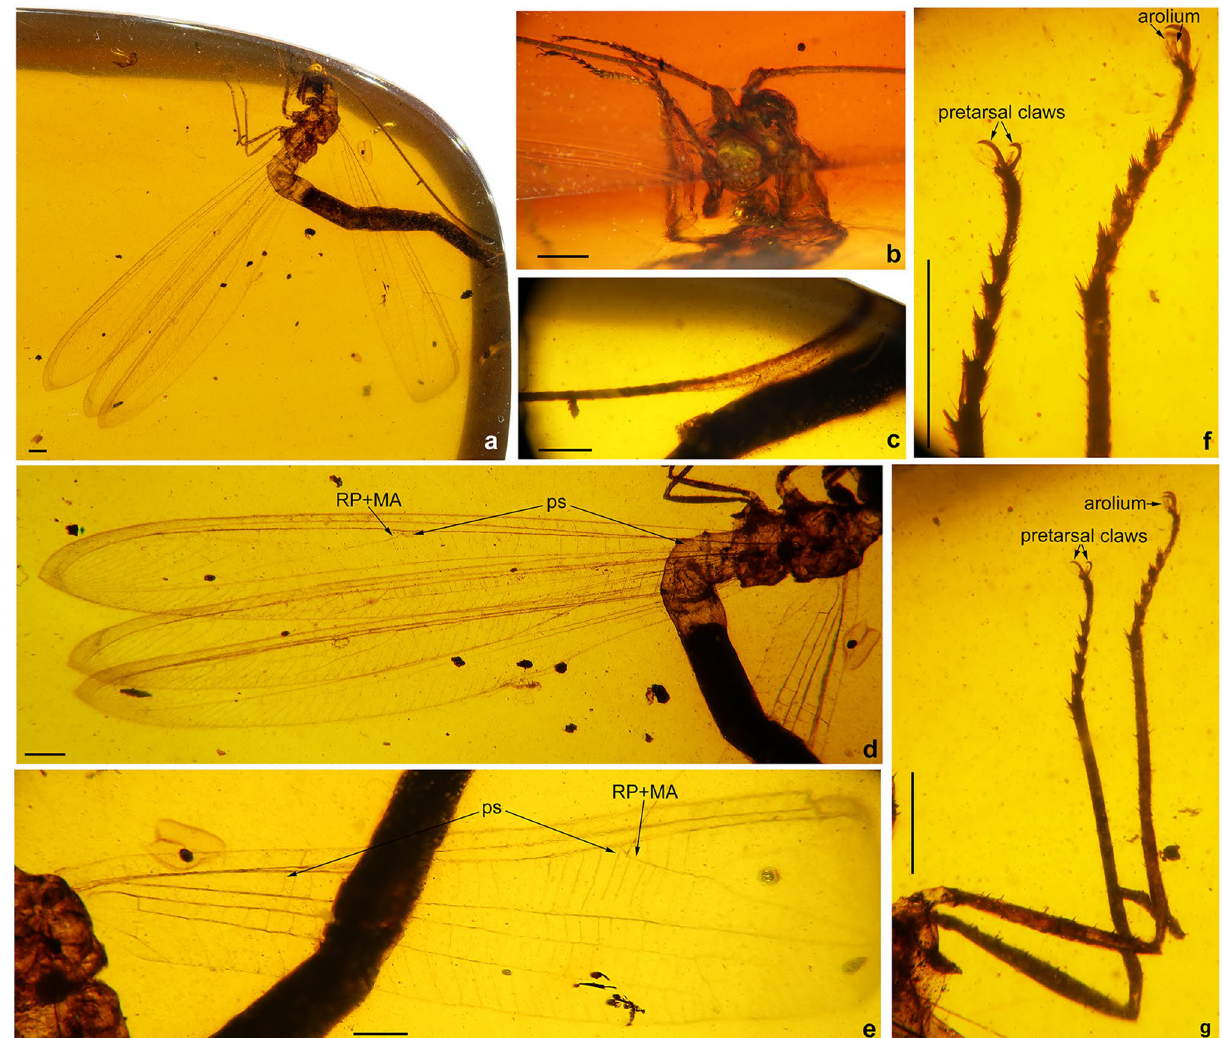
Figure 1. Calobabinskaia xiai sp. nov., holotype female. ( a ) habitus photograph, dorsolateral view; ( b ) photograph of head, dorsolateral view; ( c ) photograph of antennal apex; ( d ) photograph of left wings; ( e ) photograph of right forewing; ( f ) photograph of metatarsi; ( g ) photograph of hind legs. Scale bar = 1.0